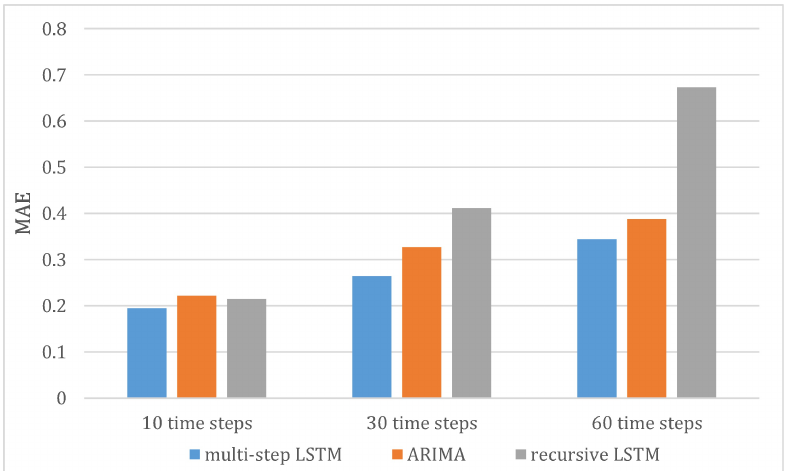
Figure 10. RMSE of three models at different output time steps.